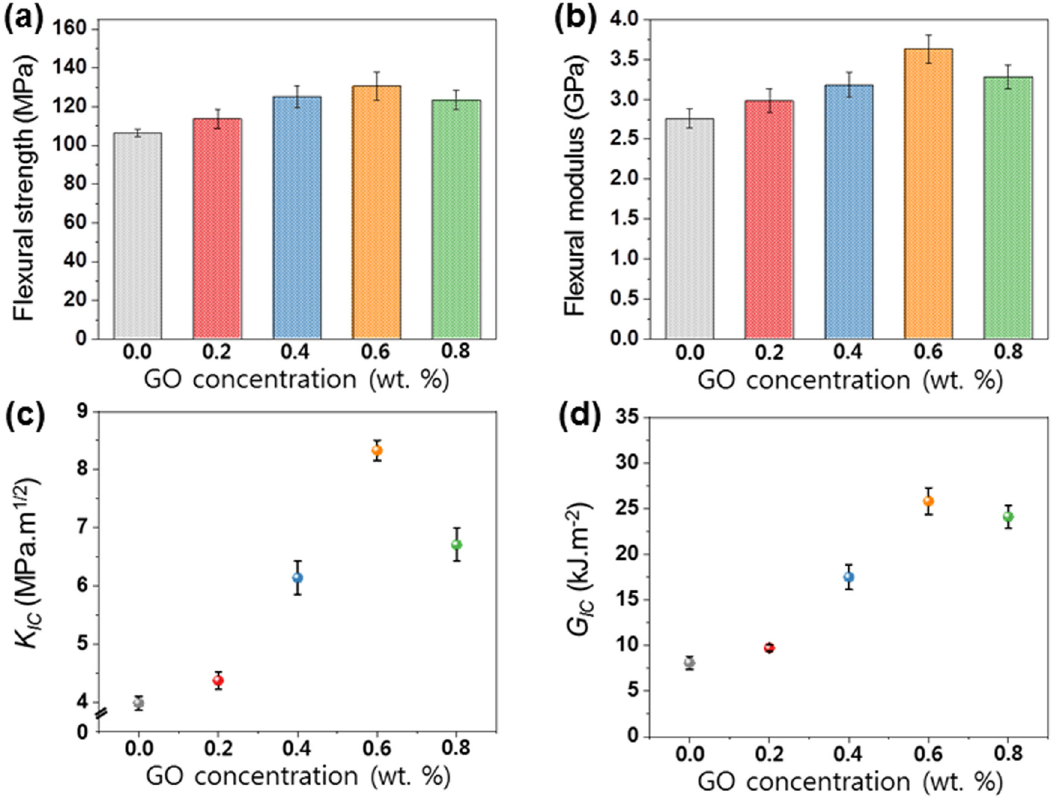
Figure 7: Mechanical properties of EP/GO nanocomposites: ( a ) fl exural strength, ( b ) fl exural modulus, ( c ) K IC , and ( d ) G IC